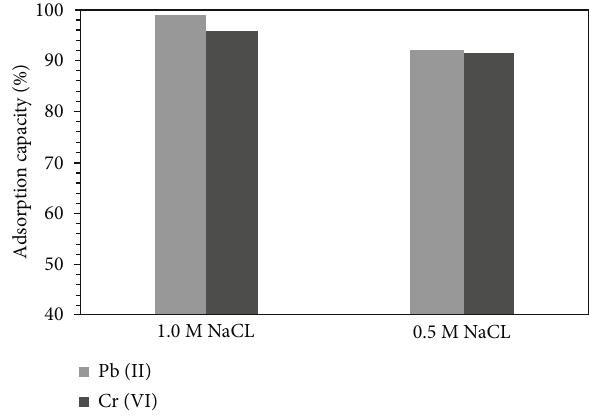
Figure 7: Regeneration of adsorbent with di ff erent concentration sodium chloride